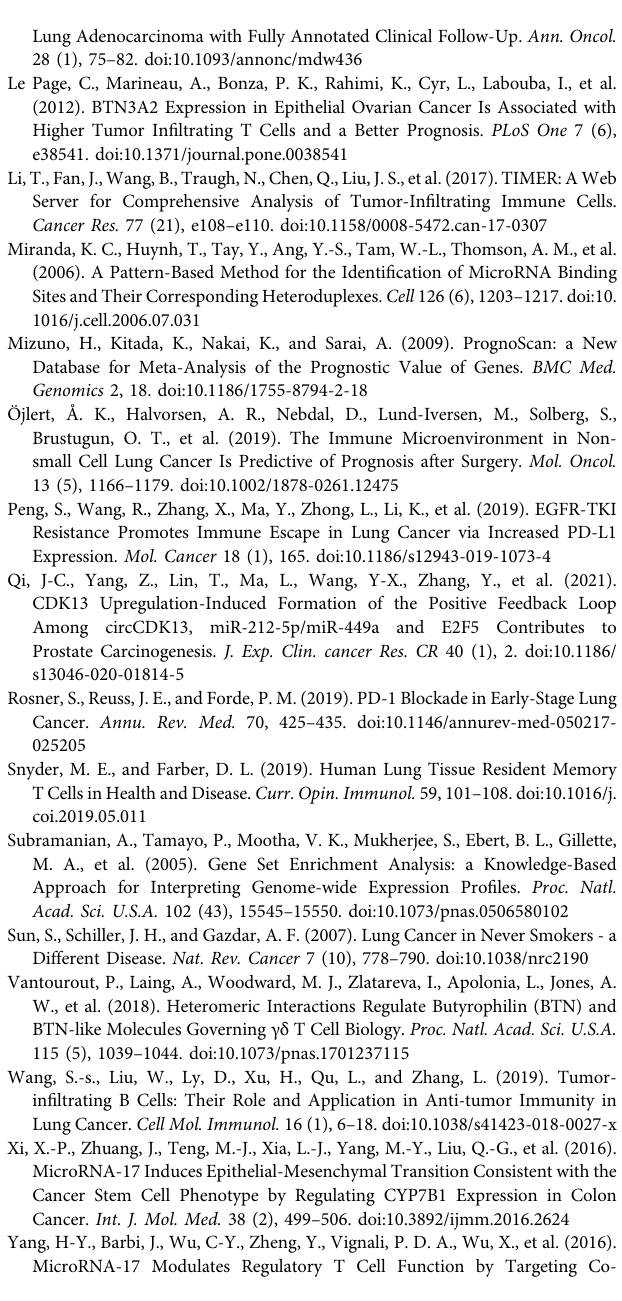
Supplementary Figure S1 | Immuno fl uorescence staining for BTN3A2 and CD3. Double immuno fl uorescence staining was used to examine the expression of BTN3A2 and CD3 in tumor and normal LUAD tissues. Supplementary Figure S2 | Gene enrichment analysis of BTN3A2 in LUAD cohorts. (A) Enriched KEGG pathway of BTN3A2-related genes. (B) Enriched GO terms of BTN3A2-related